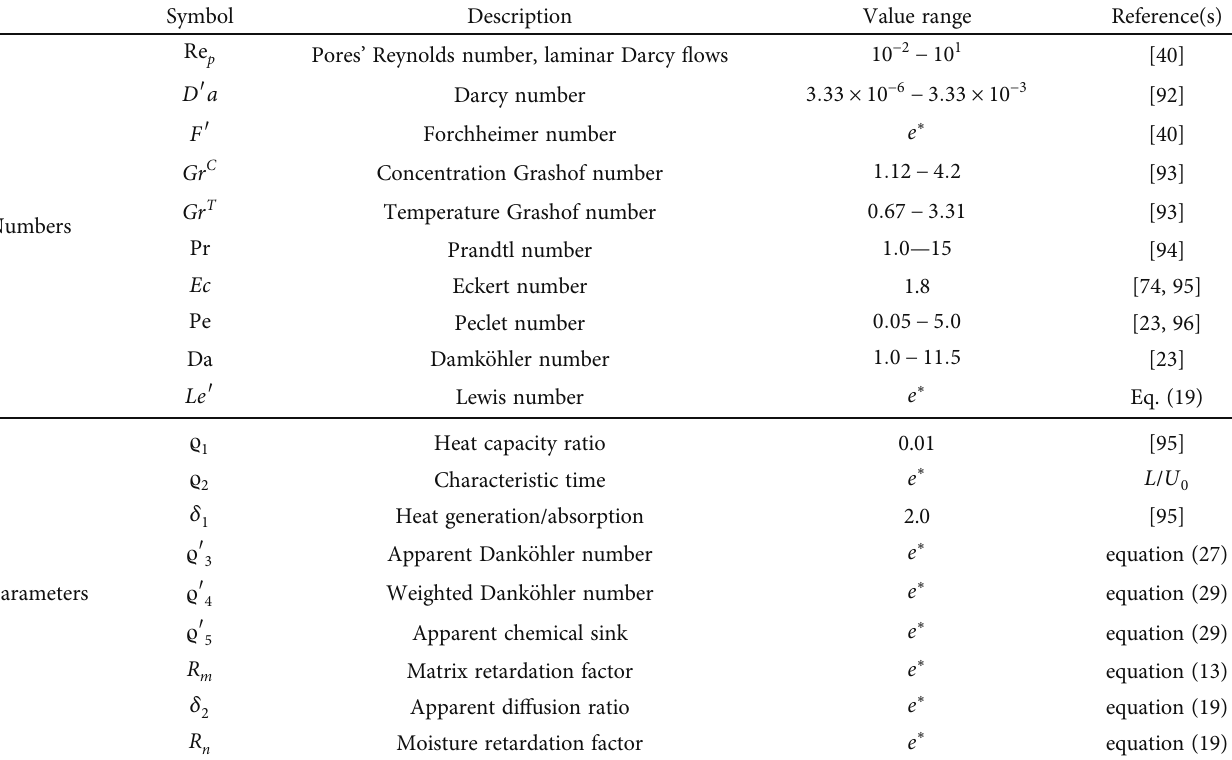
Table 1: Dimensionless model numbers and parameter